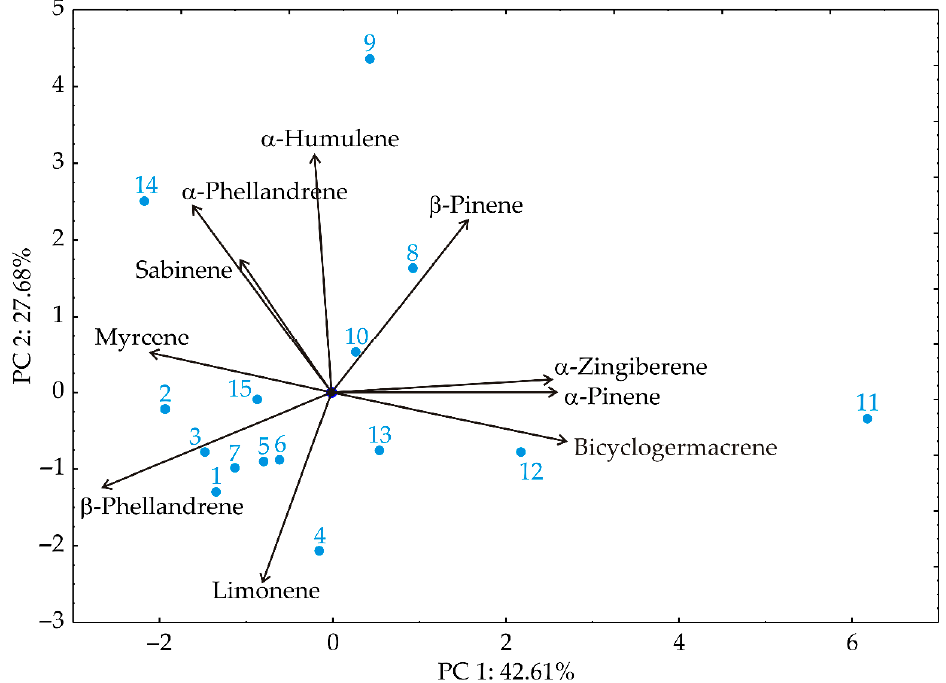
Figure 5. The PCA biplot diagram describing the relations between A. archangelica seed (fruit) volatile compounds.